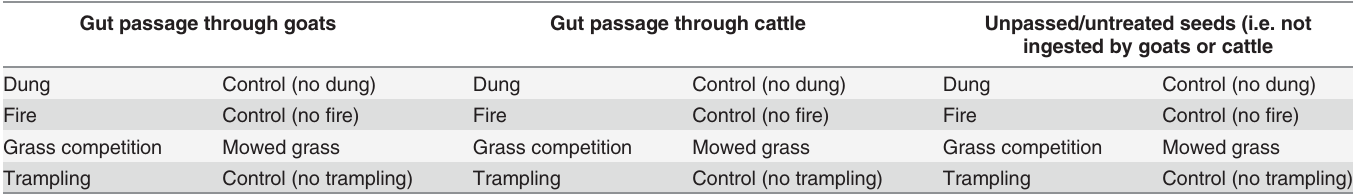
Table 1. The seedling emergence trial consisted of a completely randomized design with three replicates per treatment: passage through goats or cattle or unpassed/untreated seeds, dung, grass competition, fi re and trampling. Gut passage through